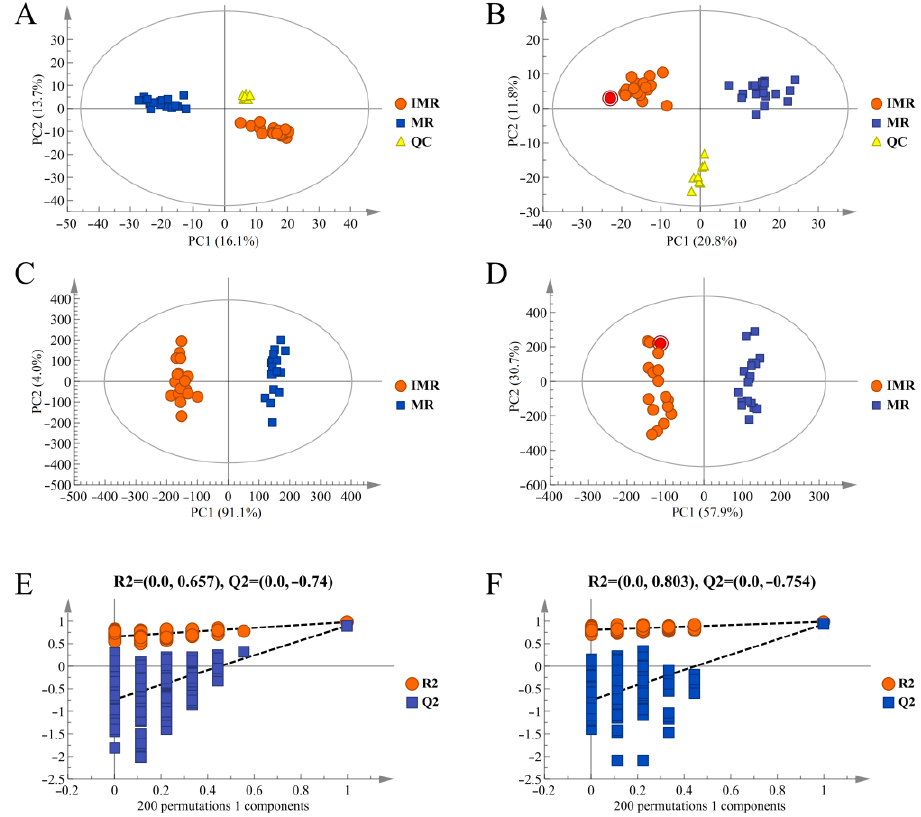
Figure 2. Changes in the hepatic metabolic profile between immature female rainbow trout and mature females. ( A ) The PCA scores plot in the positive ion mode. ( B ) The PCA scores plot in the negative ion mode. ( C ) The OPLS-DA score plot in the positive ion mode. ( D ) The OPLS-DA score plot in the negative ion mode. ( E ) The OPLS-DA permutation test in the positive ion mode. ( F ) The OPLS-DA permutation test in the negative ion mode. IMR represents immature female rainbow trout; MR represents mature female rainbow trout.